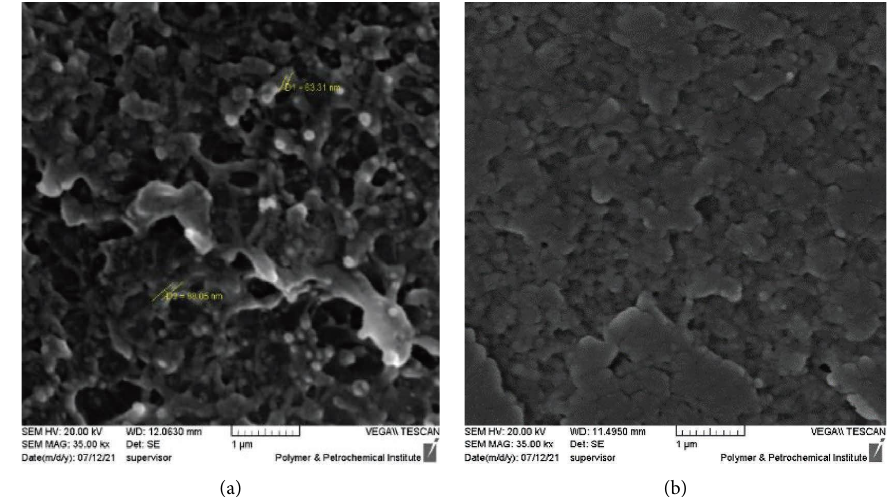
Figure 4: SEM image for PEEK/SiO 2 and PEEK. (a) PEEK/SiO 2 . (b) PEEK.